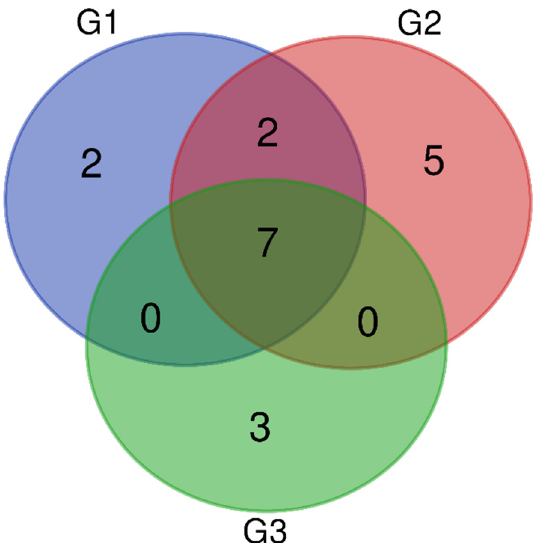
Figure 3. A Venn diagram showing the number of unique proteins (UPs) and common proteins that were identified in the epididymal spermatozoa of dogs ( Canis lupus familiaris ) in different age groups (G1, G2, G3).